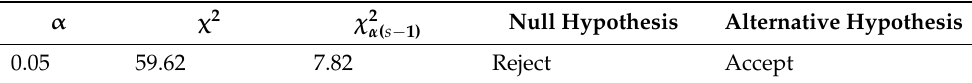
Table 8. The results of the Friedman statistic when the algorithms number s = 4 and standard instances number n = 22.